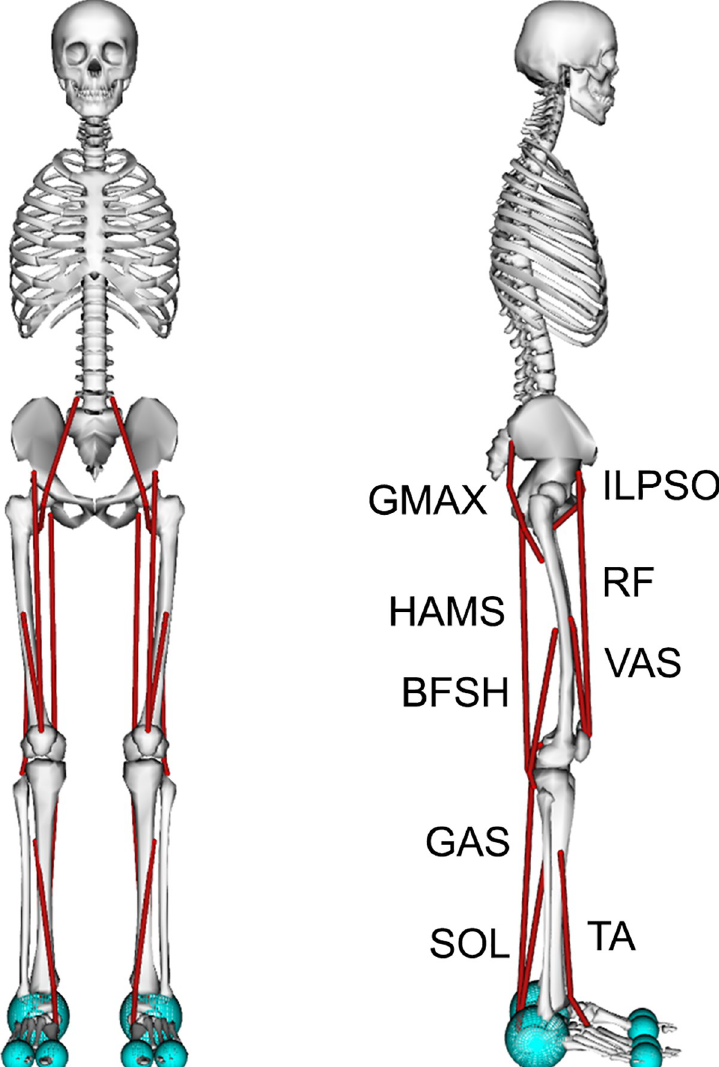
Fig 2. A planar musculoskeletal model for walking. The musculoskeletal model had nine degrees of freedom (dof). A 3-dof planar joint between the pelvis and ground was the base joint. Each hip and ankle was a 1-dof pin joint, and each knee was a 1-dof coupled joint. The model’s 18 musclulotendon actuators (red lines) represented the 9 major uniarticular and biarticular muscle groups per leg that drive sagittal plane motion: gluteus maximus (GMAX), biarticular hamstrings (HAMS), iliopsoas (ILPSO), rectus femoris (RF), vasti (VAS), biceps femoris short head (BFSH), gastrocnemius (GAS), soleus (SOL), and tibialis anterior (TA). A compliant contact model was used to generate forces between the spheres at the heel and toes of the feet and the ground